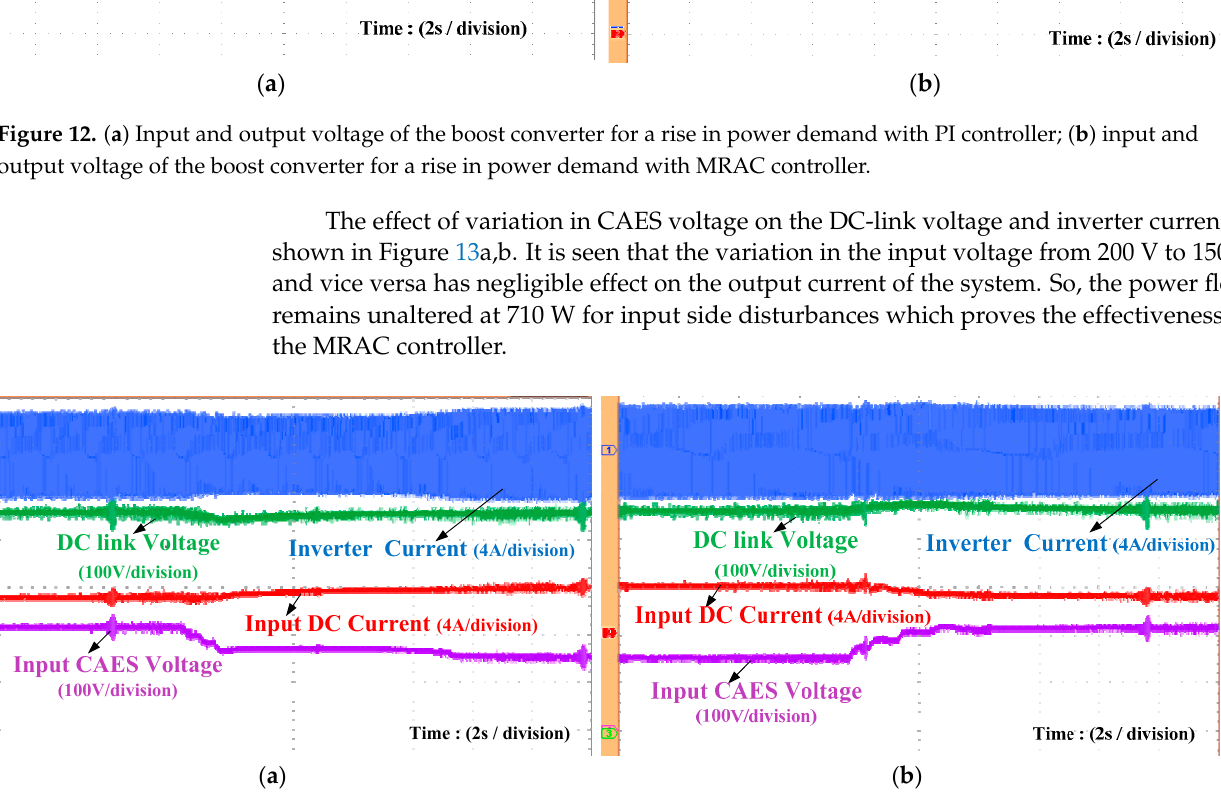
Figure 13. ( a ) Inverter current (phase A) and DC-link voltage for fall in input CAES voltage; ( b ) inverter current (phase A) and DC-link voltage for increase in input CAES voltage.